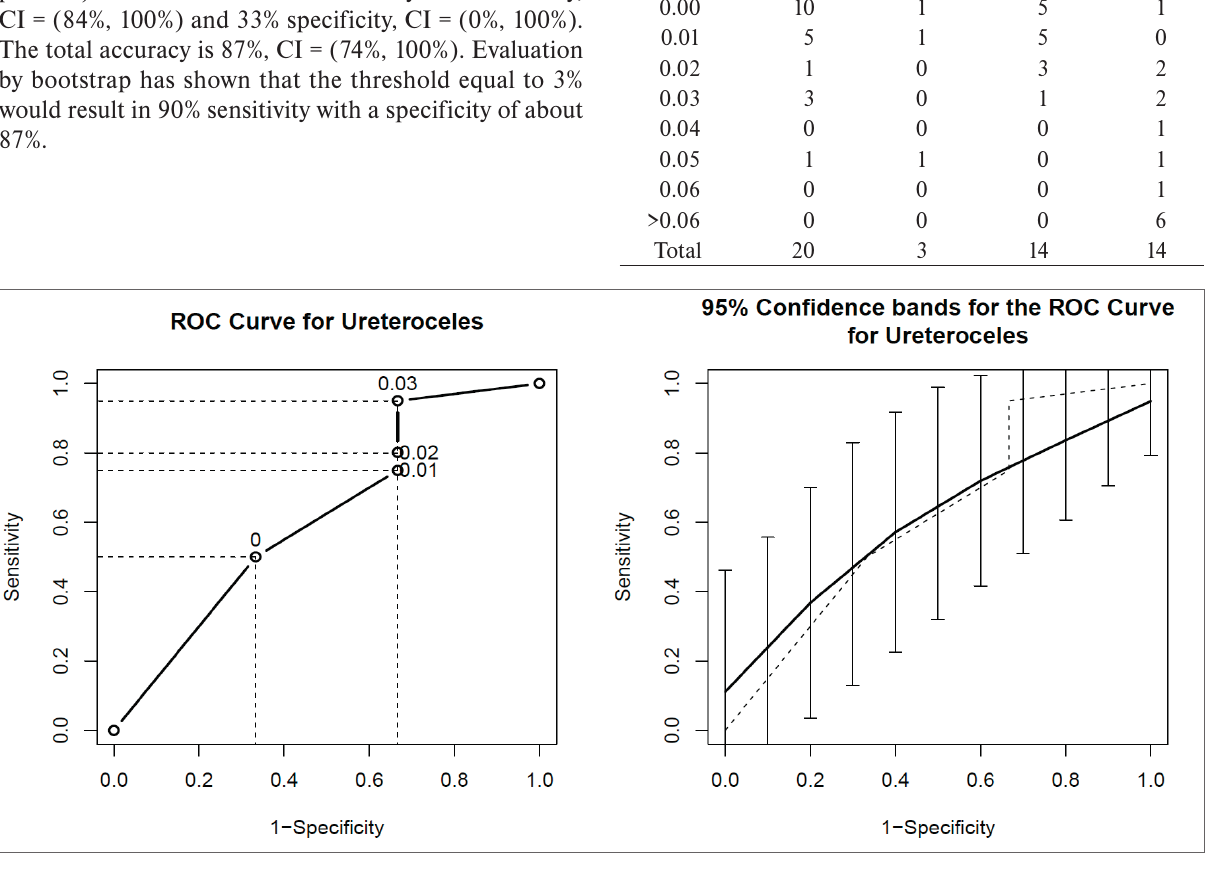
Fig. 3. roc curve illustrating the quality of predictions under various thresholds. The model predicts irreversible histological lesions in patients with the Up differential function equal to 3% or less.